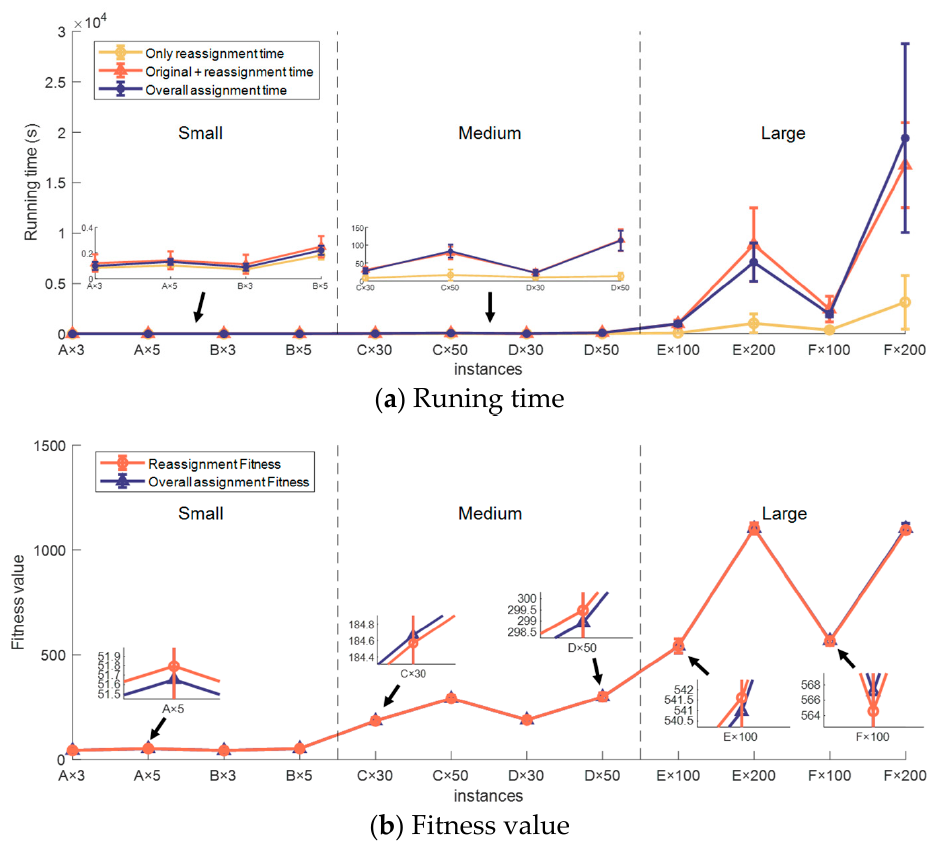
Figure 10. The reassignment results of the proposed PIDSM.